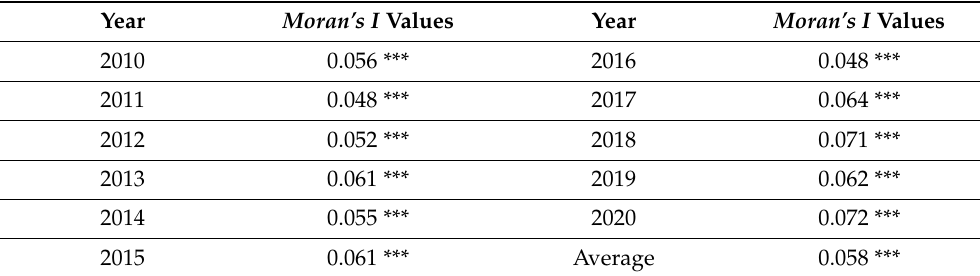
Table 2. Regional Environmental Carrying Capacity Moran’s I Statistical Values 2010–2020.